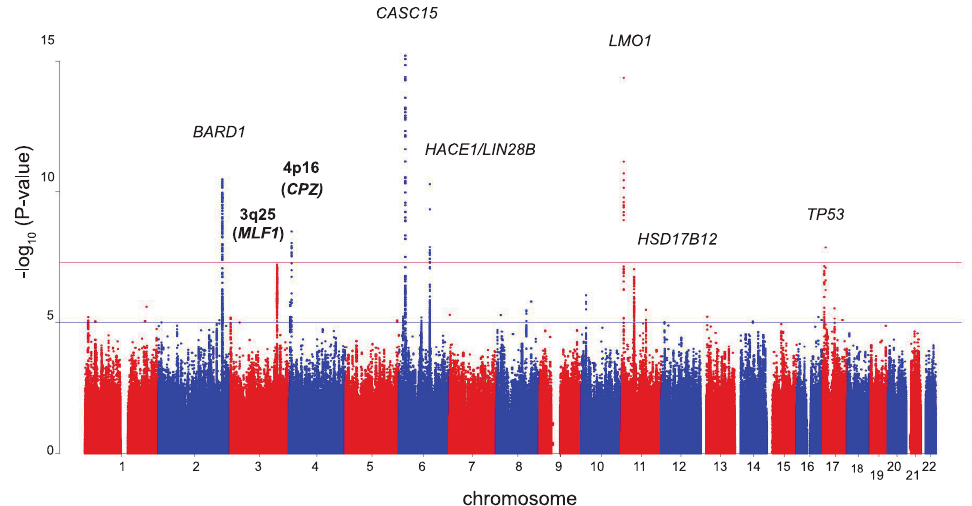
Fig 1. Manhattan plot of discovery results. Level of significance (-log 10 transformed P values) for each SNP along the genomein chromosomal order is plotted. Red line: significancethreshold of 5.0 x 10 − 8 consideredfor identification of novel loci. Previouslyidentifiedsusceptibilityloci are labeled;new associationsignalsidentified at chromosomes 3q25and 4p16 are indicatedin bold.